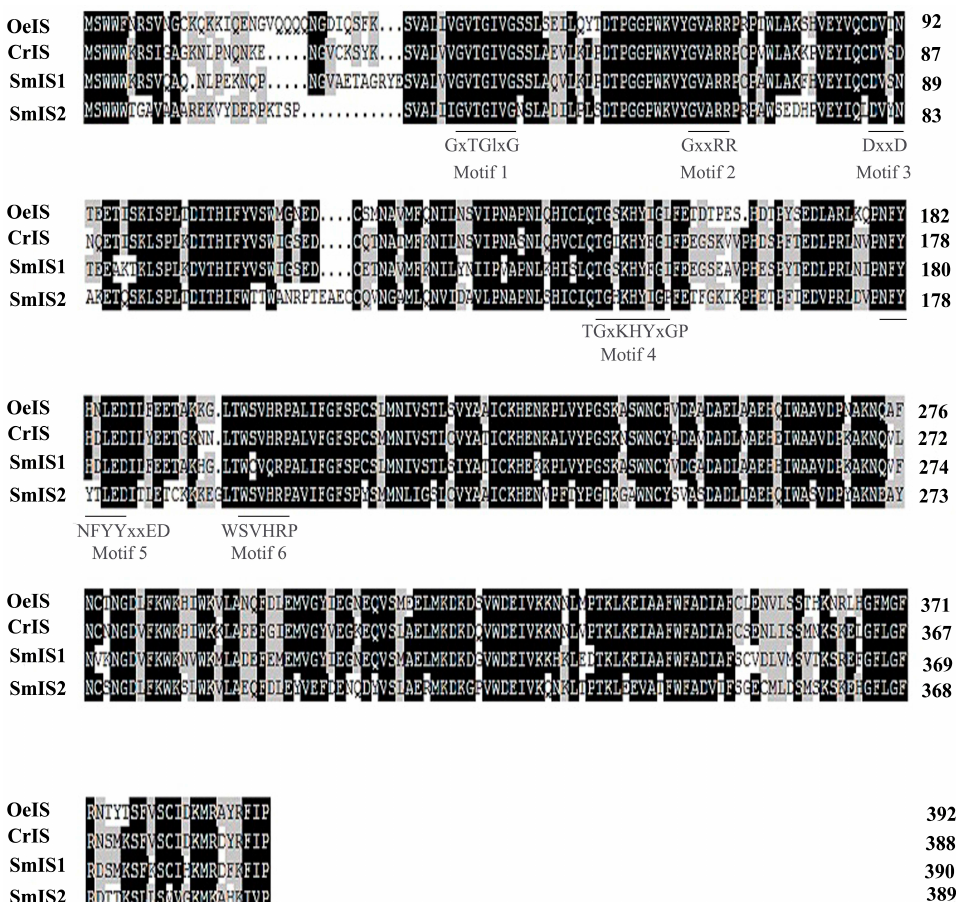
Figure 2. Amino acid sequence comparison of SmIS1 and Smis2 with other ISs. CrIS ( C. roseus , GenBank: AFW98981.1); OeIS ( O. europaea , GenBank: ALV83438.1). The conserved motifs of the P5 β Rs are indicated with bars. The highly conserved residues are highlighted in black, whereas similar residues are highlighted in grey.